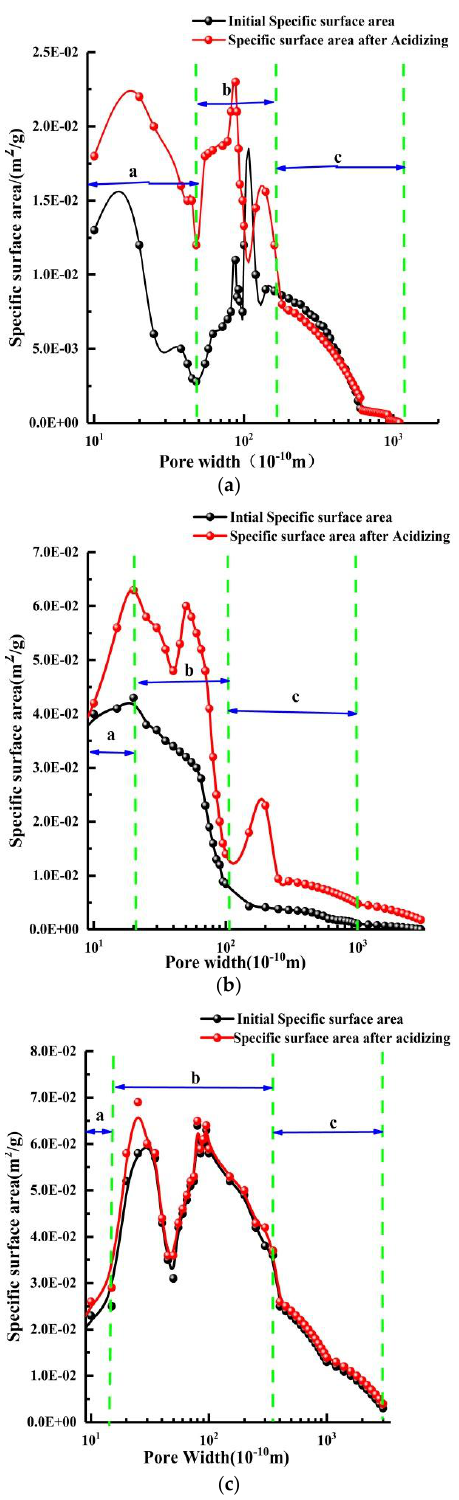
Figure 9. Relationship between S and pore width. ( a ) Qian Jiaying specimens; ( b ) Xiaonan specimens; ( c ) Liujia specimens.